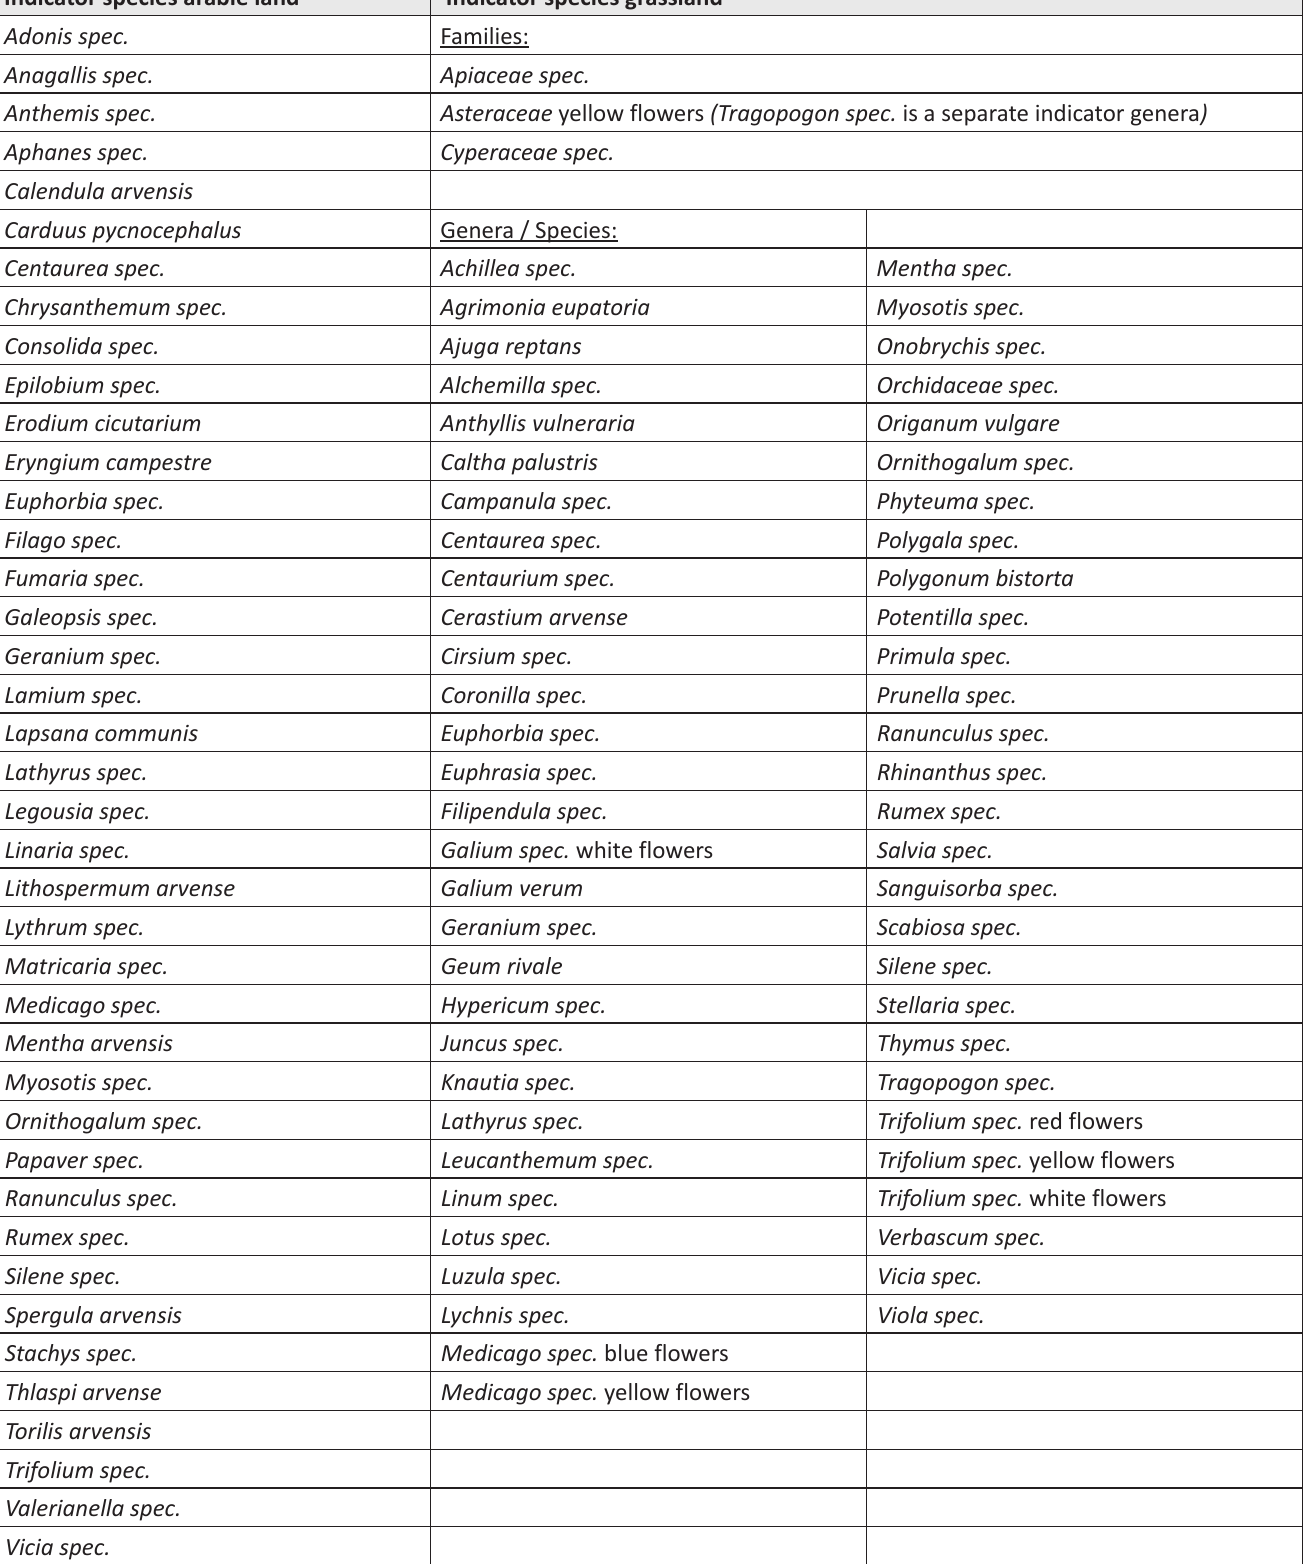
Table S2. Indicator species in grassland habitats and in arable